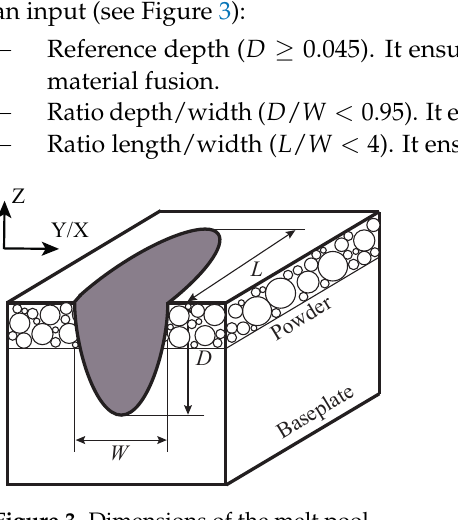
Figure 3. Dimensions of the melt pool.